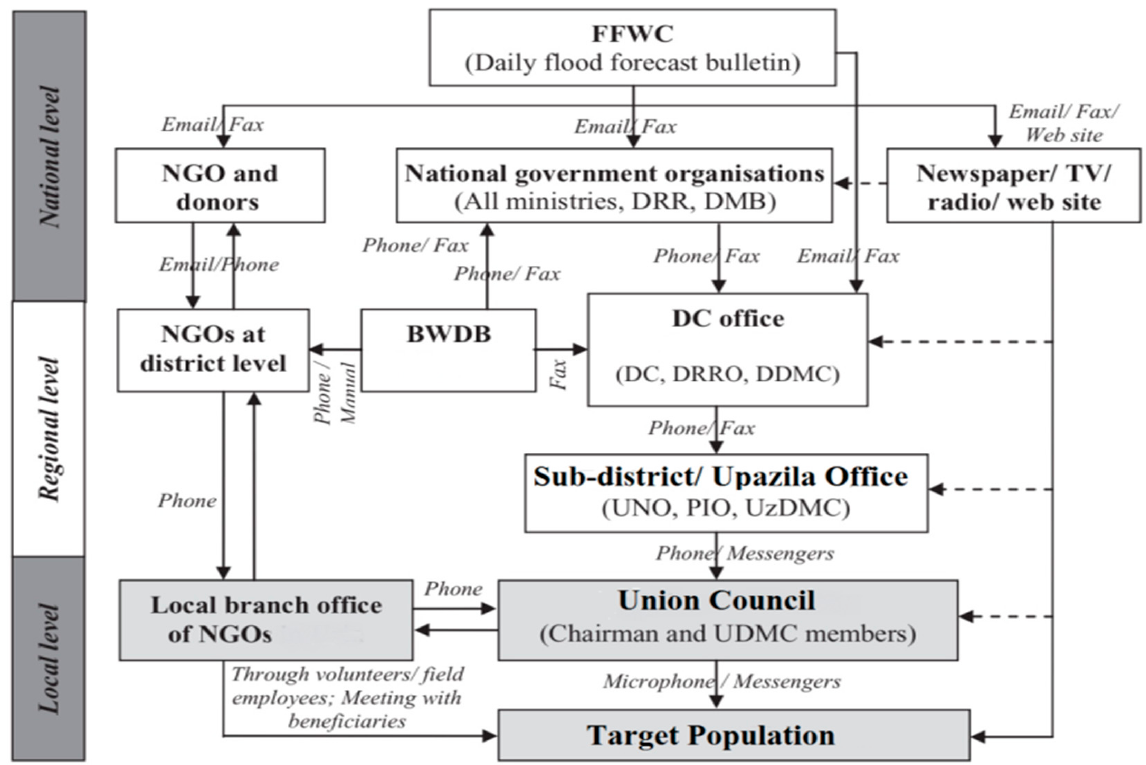
Figure 1. FEW dissemination networks from national to UC in Bangladesh (adopted from Shah et al. [7]).